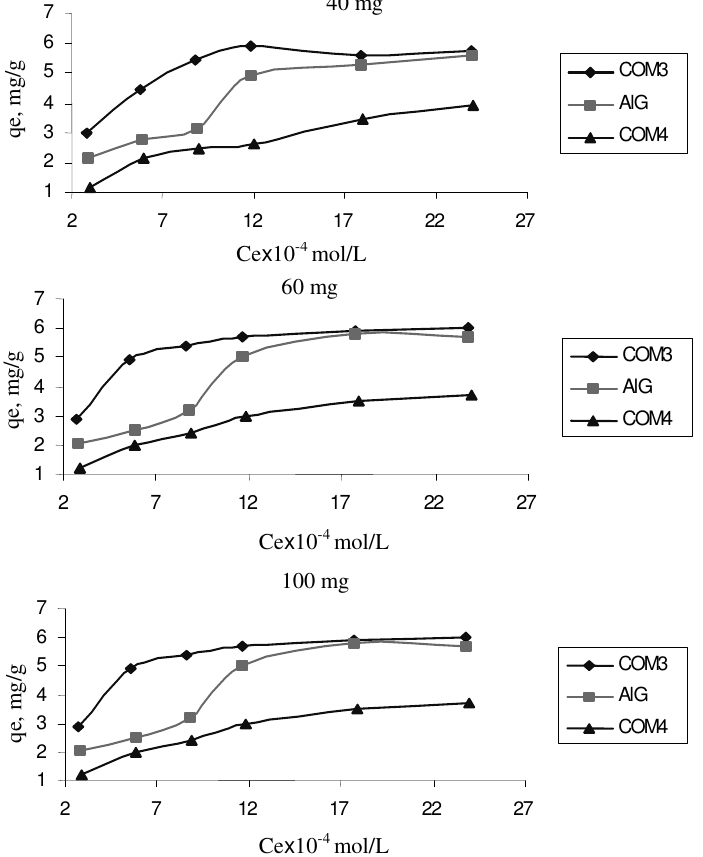
Figure 1. Adsorption isotherms of ferricyanide ions on COM3, AlG and COM4 for 40, 60 and 100 mg of